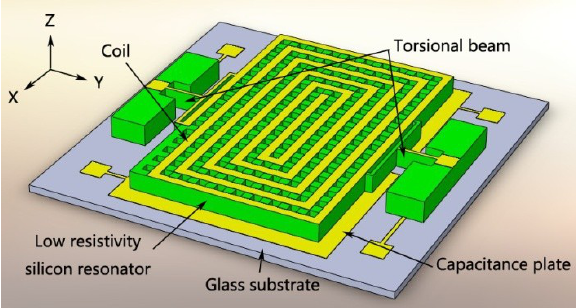
Figure 1. Principle of the microelectromechanical system (MEMS) torsional resonant magnetometer.